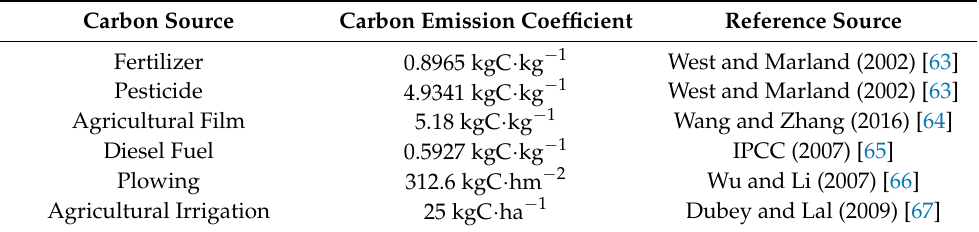
Table A1. Agricultural land use carbon emission sources, carbon emission coefficients and reference sources.